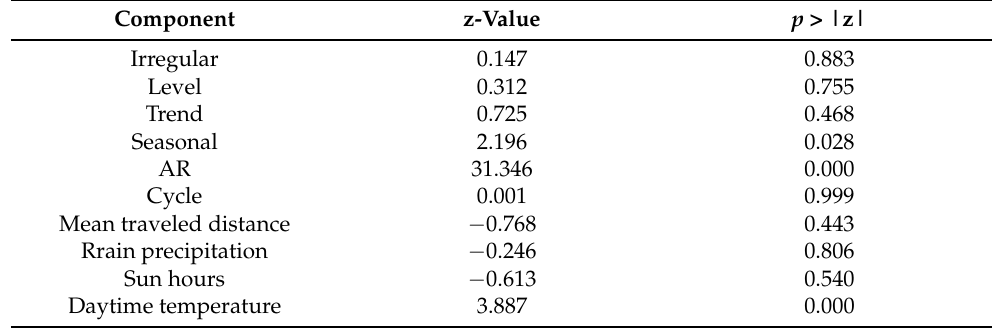
Table A2. Statistical test of UCM-components (multivariate model with FS 5 as described in Section